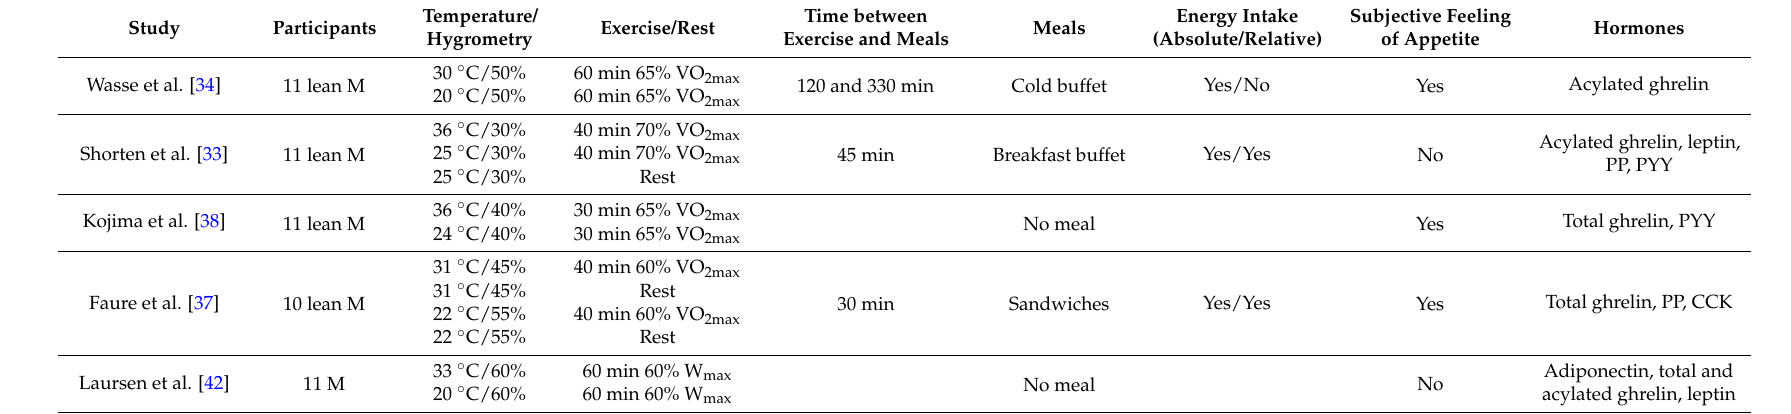
Table 1. Description of studies conducted in hot